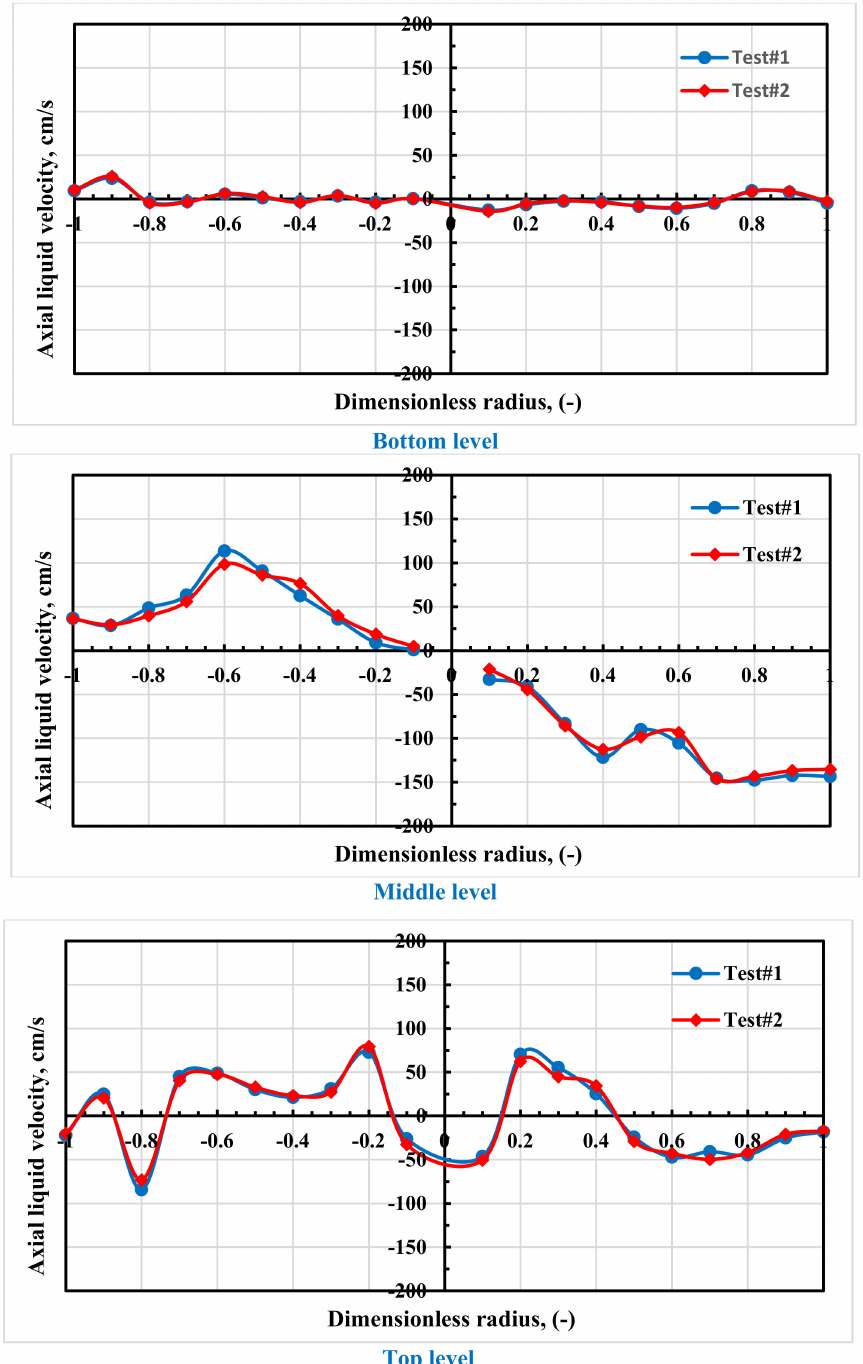
Figure 7. Reproducibility of the radial profiles in split photobioreactor at top level and operated at gas velocity of 3